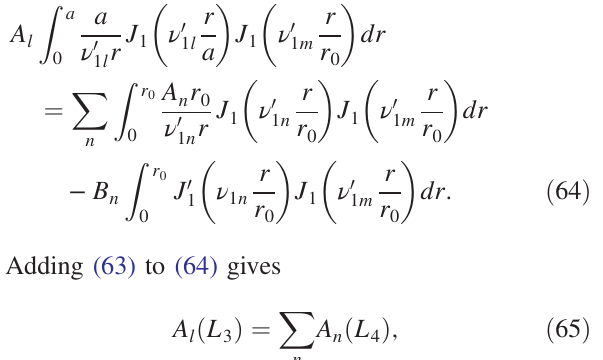
FIG. 6. Comparison of the rhs (green color line) with the lhs (dashed black line) of Eq. (53) for E upper limit of the sums truncated at 300 terms and the ð A values substituted from the results in (62) and (70). In this plot, we took r 0 =a ¼ 2 as an